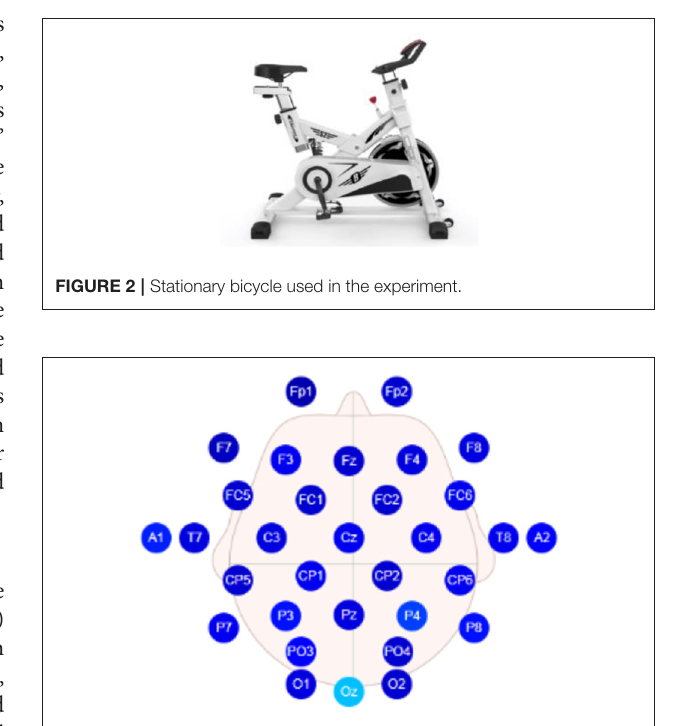
FIGURE 3 | Electrode placement for Neuracle